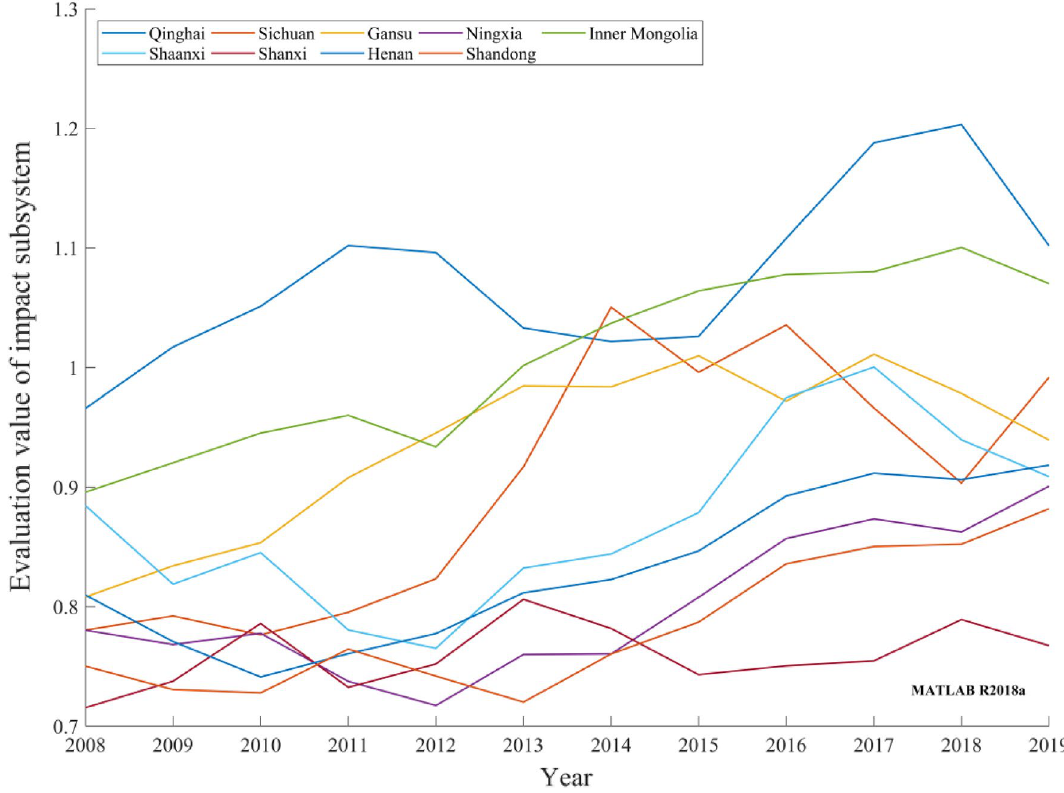
Figure 6. Evaluation values of provincial carbon-neutral impact subsystems in the Yellow River basin during